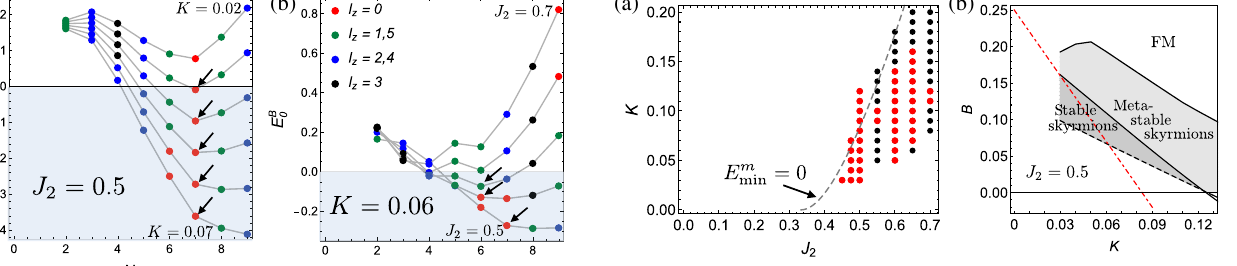
FIG. 3. Binding energy of N f down spins embedded in a ferromagnet as a function of N f . Negative values fulfilling the inequality (4) are stable multispin bound states, often with skyrmion signatures (see Fig. 2). The arrows denote the states with the lowest binding energy per flipped spin, which are expected to proliferate in the thermodynamic limit. (a) K is varied from 0.02 (top curve) to 0.07 ( J 2 ¼ 0 . 5 ). (b) J 2 takes values from 0.5 to 0.7 in steps of 0.05 ( K ¼ 0 . 06 ).